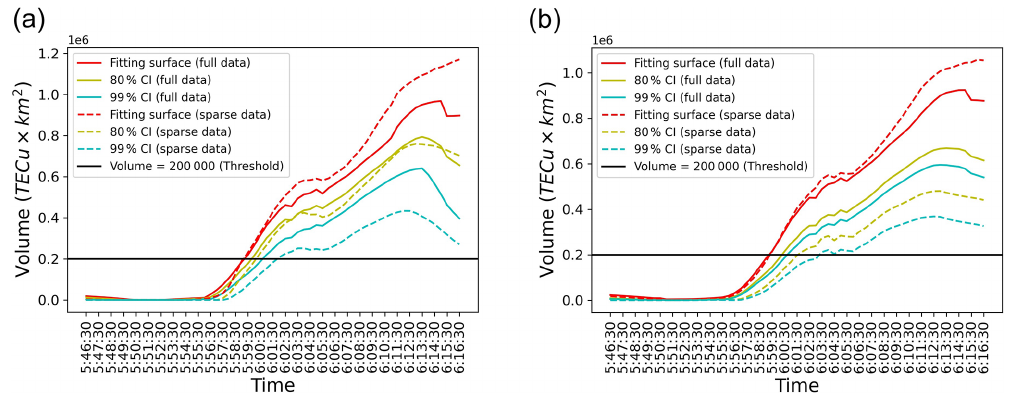
Figure 15. The time series of TIH volume for full data and sparse data with a one-sided CI. The red solid line is the volume calculated with a fitting surface for full data. The solid yellow line and the solid blue line are a one-sided 80% CI and 99% CI, respectively. The dashed lines are for sparse data with only 5% of receivers. The horizontal black line is a provisional threshold. Panel (a) shows the TEC surface computed based on GP regression. Panel (b) shows the TEC surface computed based on GP regression using the INLA-SPDE